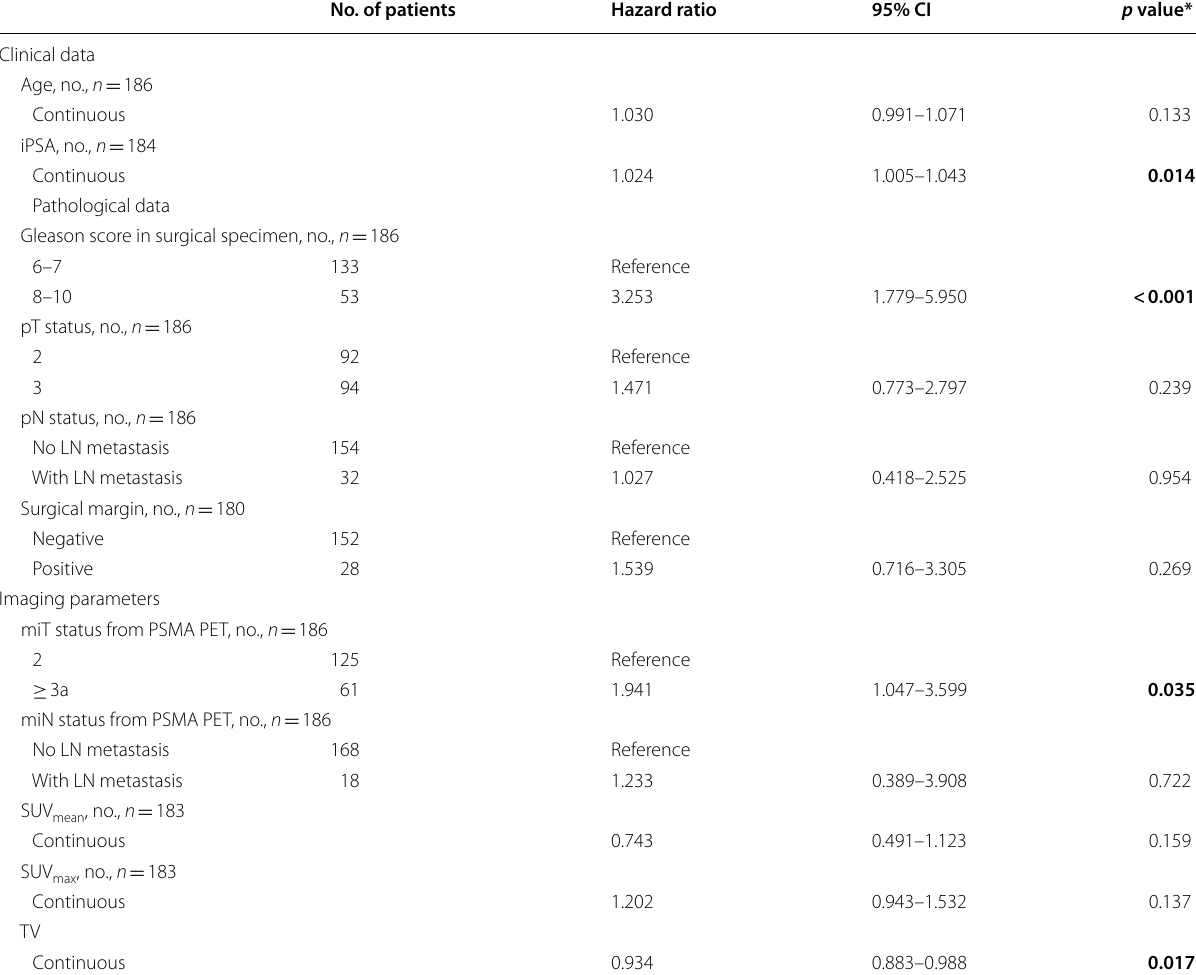
Table 7 Multivariable analysis for the association of baseline factors with BCR‑free